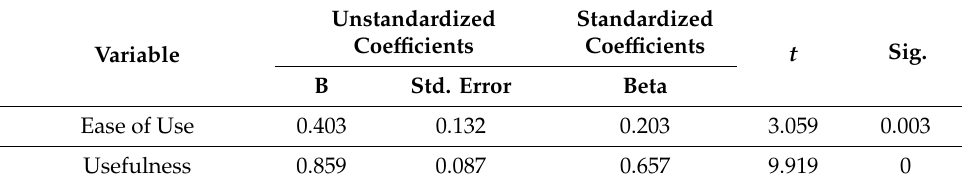
Table A3. Analysis result of ease of use, usefulness, and attitude (dependent variable: attitude).